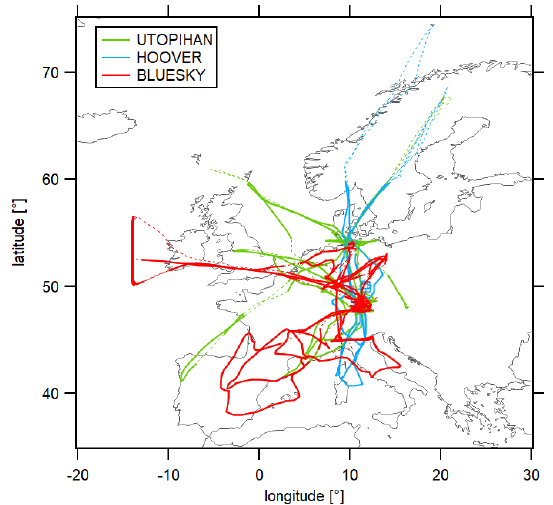
Figure 1. Overview of the flight tracks of the considered air- craft campaigns: UTOPIHAN (2003 and 2004) in green, HOOVER (2006 and 2007) in blue and BLUESKY (2020) in red. Solid lines present the data considered in this study (filtered for troposphere and south of 60 ◦ N), and dashed lines show the complete flight